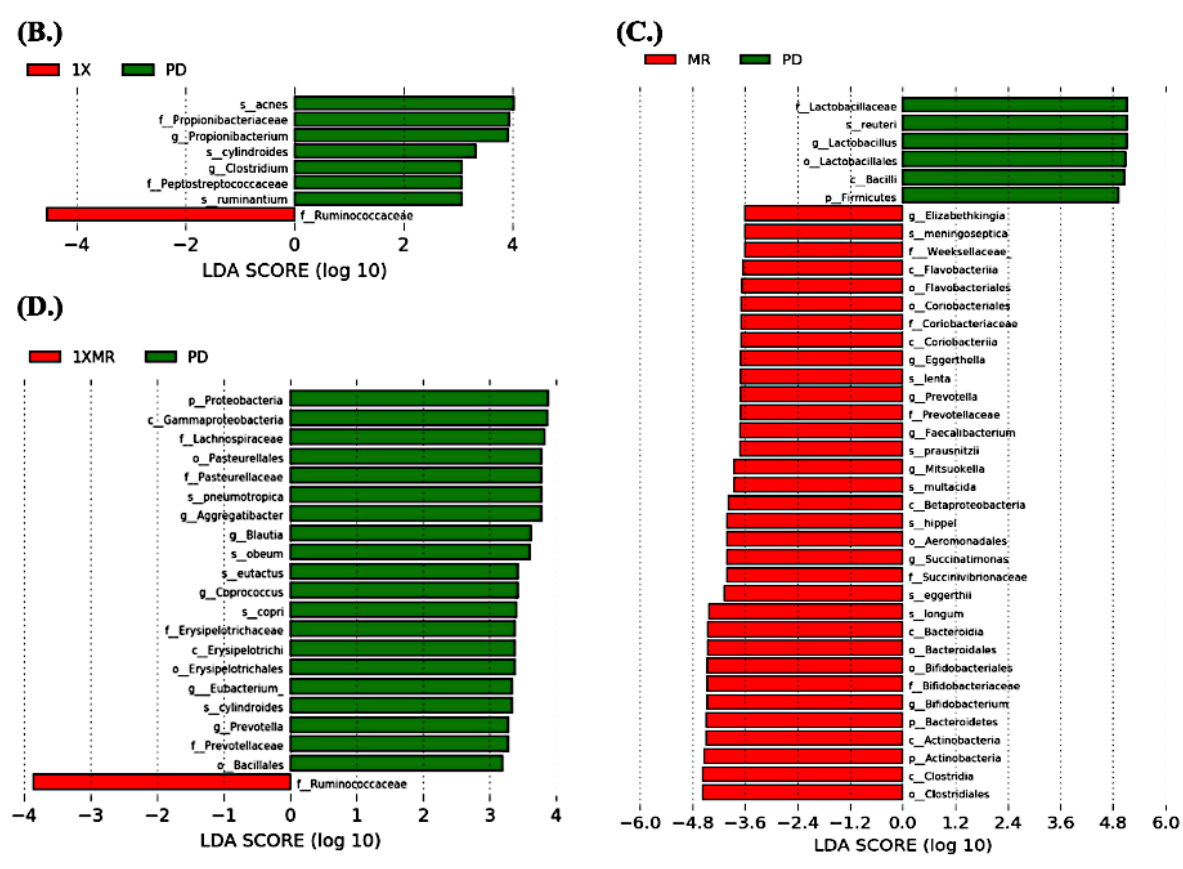
Figure 5. Comparison of the fecal microbiome between groups, highlighting the enriched taxa after 8 weeks of treatment. Linear discriminant analysis effect size (LEfSe) along with the identity of fecal bacterial markers that discriminated between the ND, PD, LD, 1X, MR, and 1XMR groups. ( A ) Linear discriminant analysis (LDA) scores for differentially abundant taxa between the ND, PD, LD, 1X, MR, and 1XMR groups are shown on the right. ( B ) Linear discriminant analysis (LDA) scores for differentially abundant taxa between the PD and 1X groups. ( C ) Linear discriminant analysis (LDA) scores for differentially abundant taxa between the PD and MR groups. ( D ) Linear discriminant analysis (LDA) scores for differentially abundant taxa between the PD and 1XMR groups. The input criteria for the LEfSe analysis included a LDA score >3 (log 10) and an alpha value of 0.01 for the factorial Kruskal–Wallis test/pairwise Wilcoxon test. ND, non-diseased; PD, untreated PD; LD, PD treated with 8 mg of L-DOPA; 1X, PD supplemented with the probiotic; MR, PD supplemented with MR as prebiotic; 1XMR, PD supplemented with a combination of 1X and MR.